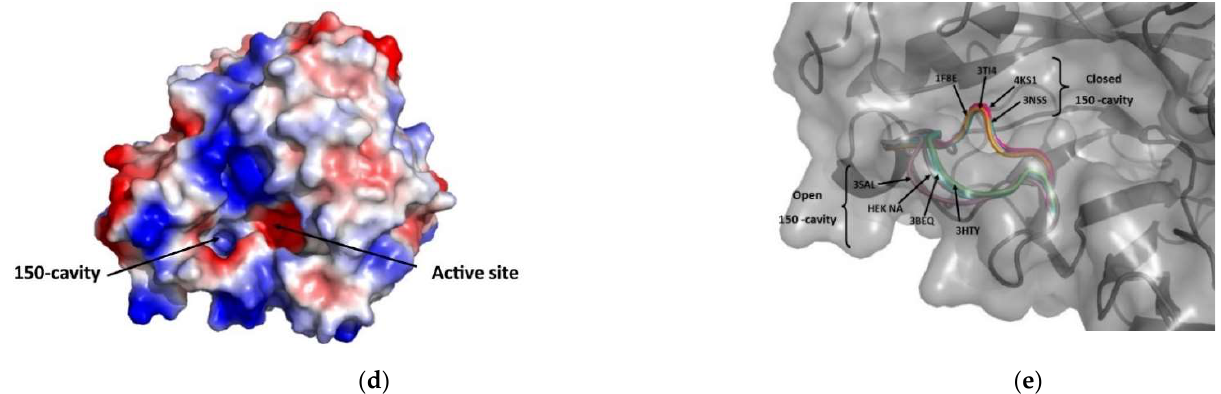
Figure 8. Conserved structural features of NA produced by HEK293-6E cells. ( a ) Coordination of the central Ca 2+ ion. ( b ) Coordination of Ca 2+ ion 1. ( c ) Coordination of Ca 2+ ion 2. ( d ) Open 150-cavity observed for HEK NA. 150-cavities of other NAs can be found in supplemental Figure S4. ( e ) Position of 150s-loop. The HEK NA structure (chain A) is represented by a transparent grey surface and dark grey cartoon secondary structure. The 150s loop of published NA structures have been superposed onto the HEK NA structure. Cyan 3BEQ. Light pink 3SAL. Grey 1F8E. Purple 4K1K. Orange 3TI4. Dark Green 2HTY. Teal 3NSS. Hot pink 4KS1.